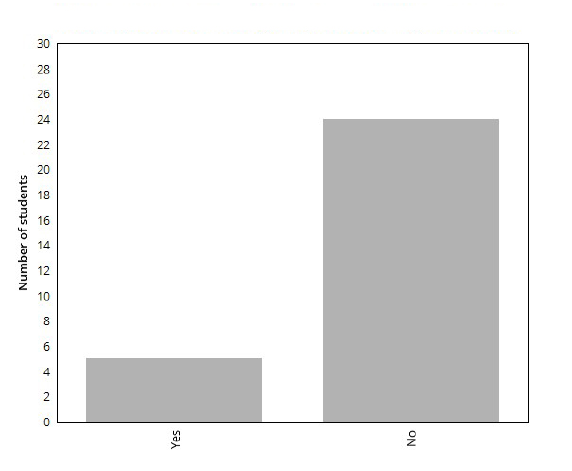
Figure 7. Prior experience investigating a community, town or